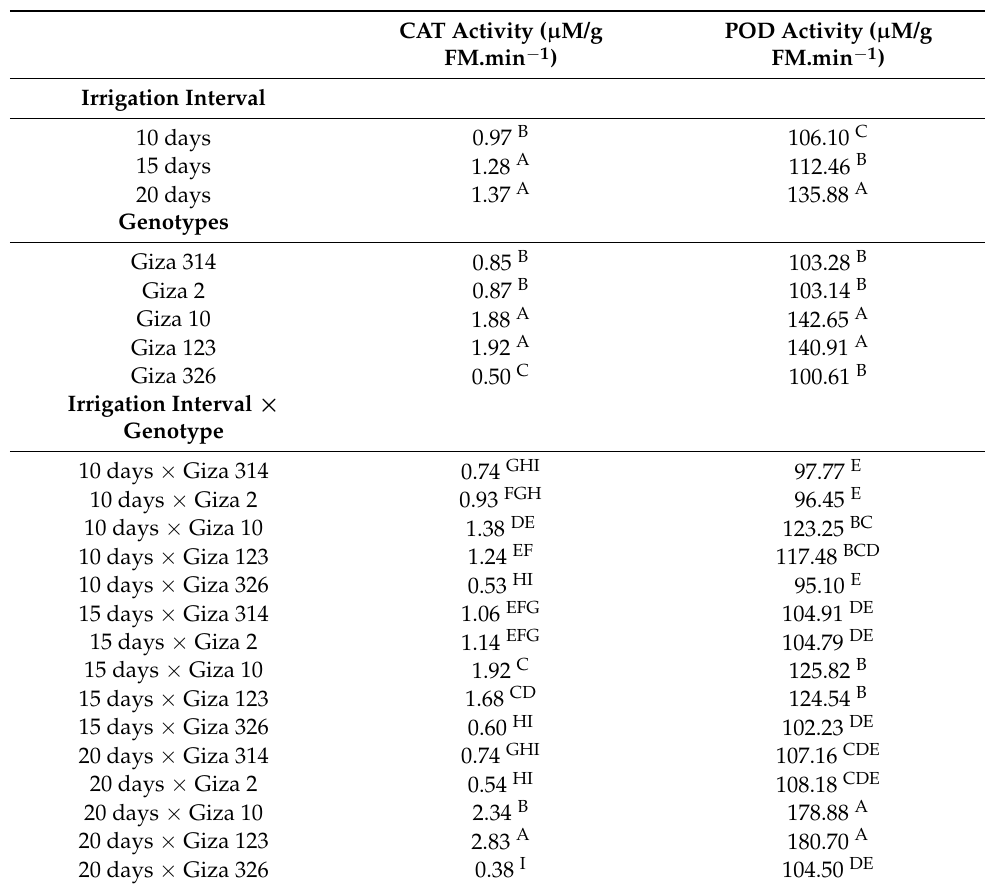
Table 7. Antioxidant enzymes of five maize genotypes as affected by normal (10 days), mild (15 days), and severe (20 days) water stress at the vegetative stage. Means within the same column distinguished by different letters differ significantly according to the Tukey’s posthoc HSD test at p =